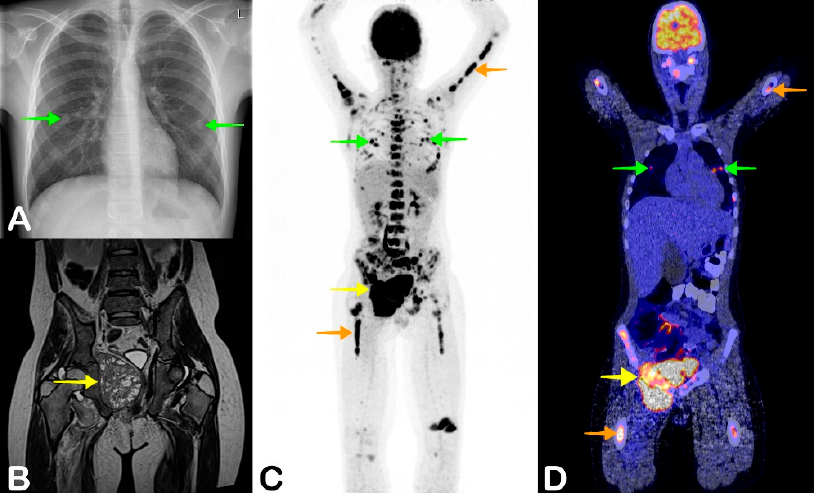
Figure 2. A 13-year-old boy presented to the hospital with a fever of three weeks, weight loss, and general malaise. He also had nonspecific pain in his legs and back and complained of nausea and vomiting. On physical examination, hepatomegaly was noticed. Laboratory testing showed normocytic anemia with a hemoglobin level of 5.2 mmol/L, leukopenia with a leukocyte count of 0.8 × 10 9 /L, and elevated lactate dehydrogenase of 300 U/L. Abdominal ultrasonography confirmed the hepatomegaly, but showed no clear cause of the fever. A chest X-ray showed multiple pulmonary nodules ( A , green arrows), suggestive of metastases of an unknown primary tumor. Because the patient had multiple nonguiding symptoms, FDG-PET/CT was performed. Coronal maximum intensity projection FDG-PET and fused FDG-PET/CT showed a large FDG-avid mass in the right lesser pelvis ( C and D , yellow arrow), multiple pulmonary metastases ( C and D , green arrows), and focally FDG avid bone marrow ( C and D , orange arrows). Biopsy confirmed the diagnosis of metastasized Ewing sarcoma. MRI was performed before treatment was started, which also showed the primary site of the Ewing sarcoma in the right side of the pelvis ( B , yellow arrow). After chemotherapy, radiotherapy, and an autologous stem cell transplant, the patient recovered and remained in complete remission for five years of